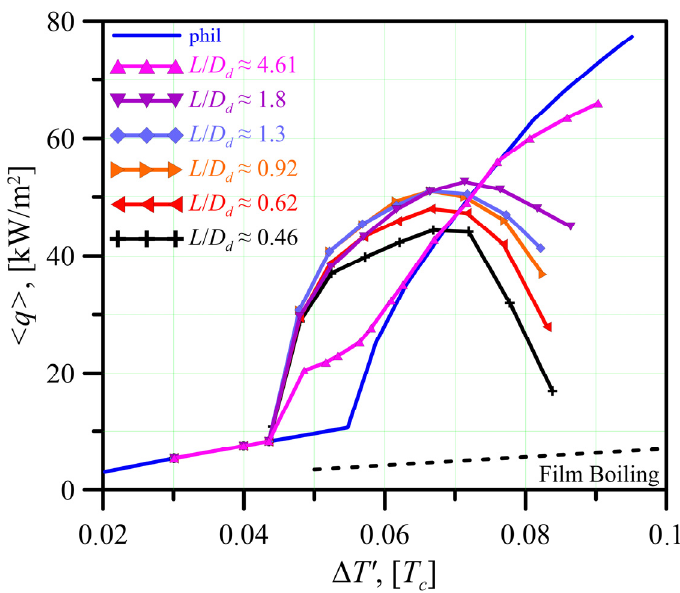
Figure 7. Boiling curves q( Δ T ′ ) for the smooth surfaces with contrast wettability. Lyophobic zone width D phob = 450 µm, space separation between the zones L / D d = 0.46, 0.62, 0.92, 1.3, 1.8 and 4.61.